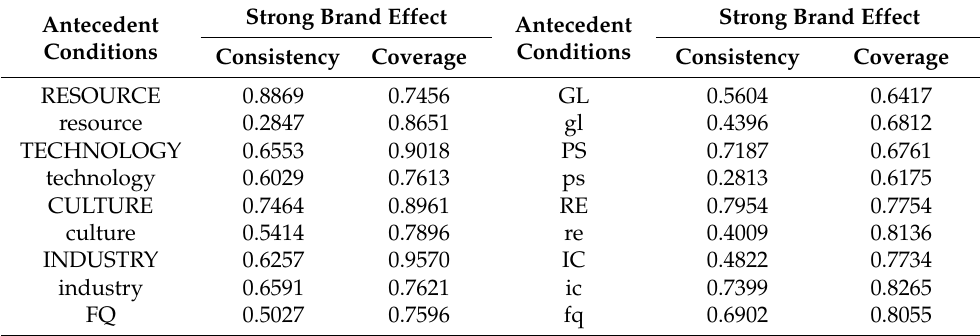
Table 3. Analysis of the necessary conditions for a strong brand effect.